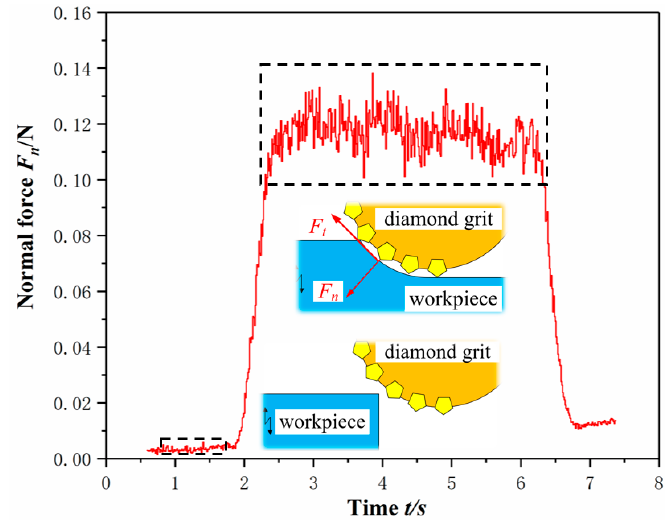
Figure 6. Typical curve of sawing force in feeding direction versus sawing time.